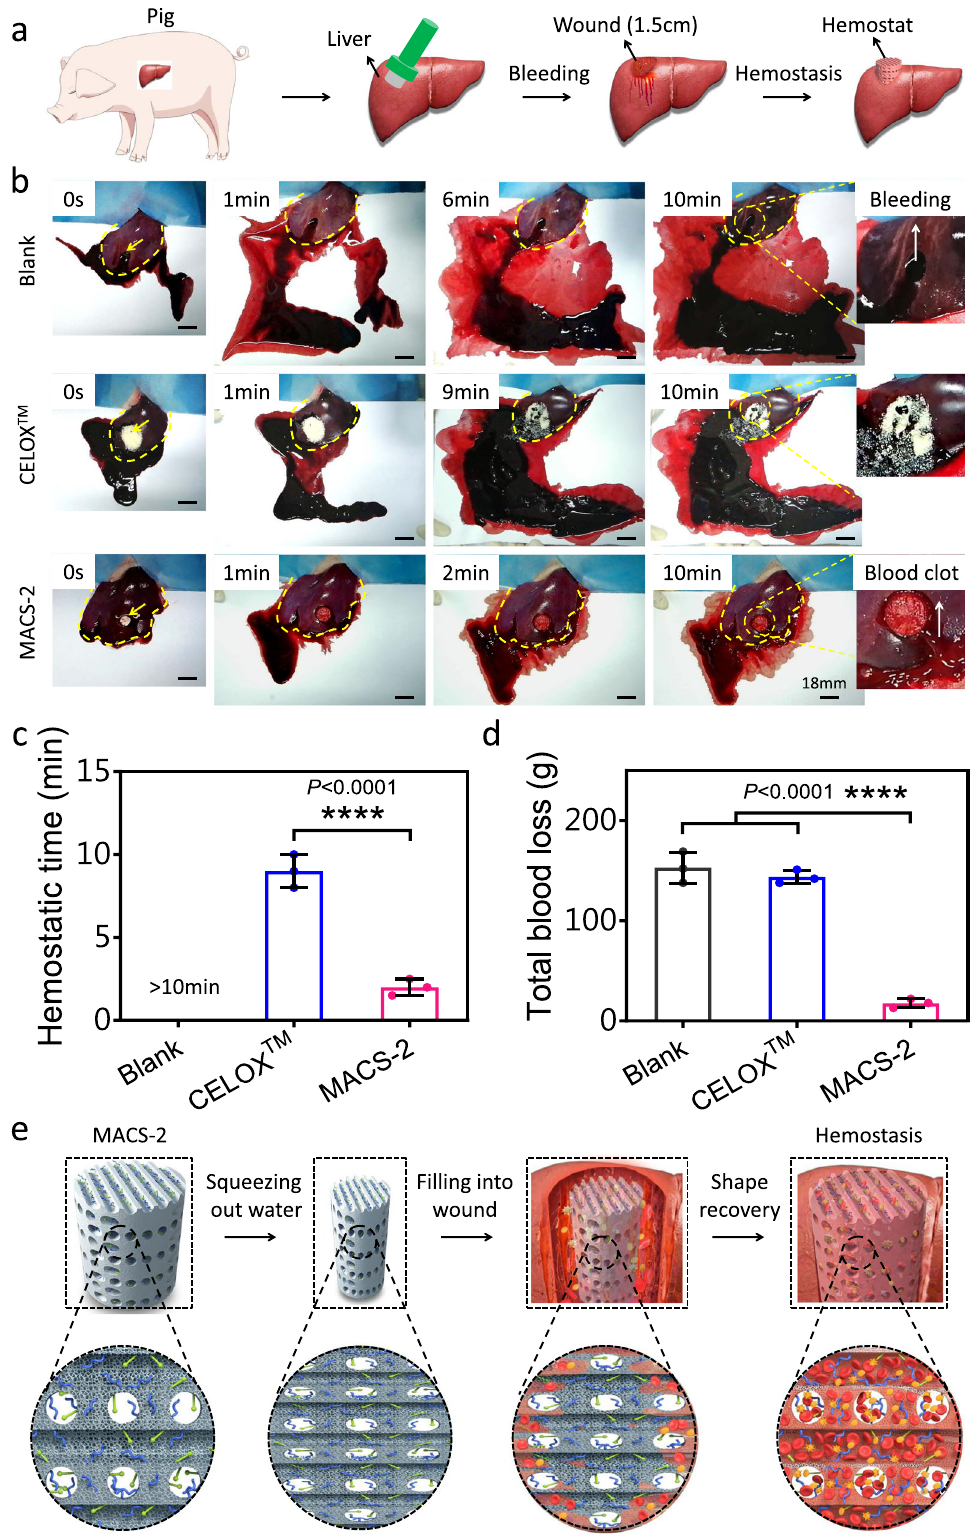
Fig. 7 Hemostasis in a lethal pig liver perforation wound model. a Schematic illustration of the hemostatic process of hemostats in a lethal pig liver perforation wound model. b Photographs of the hemostatic effect of the blank, CELOX TM , and MACS-2 groups. The yellow arrow and dotted line represented the boundary of the liver and the bleeding site, respectively. c , d Hemostatic time and total blood loss in the blank, CELOX TM , and MACS-2 groups. n = 3 pigs per group. Data are expressed as mean ± SD. The signi fi cant difference was detected by one-way ANOVA with Tukey ’ s multiple comparisons test. ****P < 0.0001. e Schematic diagram of hemostatic procedure and mechanism of the